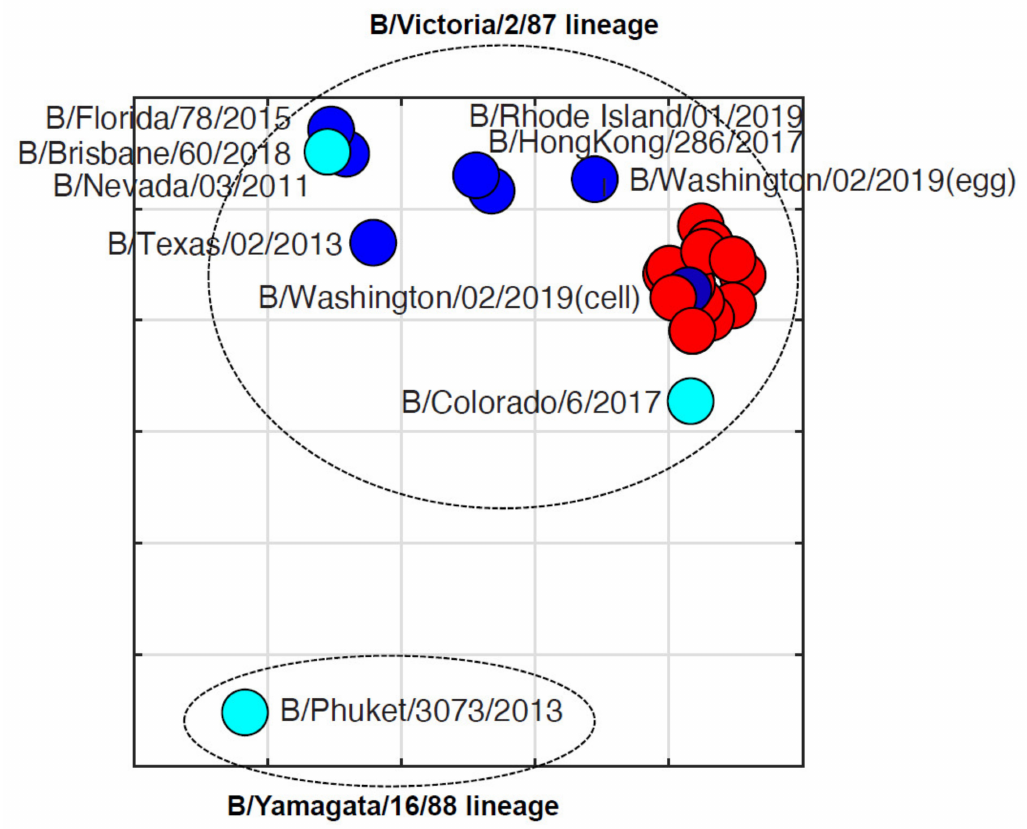
Figure 4. Antigenic cartography of hemagglutination inhibition results of influenza B virus isolates (2019–2020). Each grid represents one unit, a 2-fold change in hemagglutination inhibition titers. The vaccine component strains are labeled in cyan. Strains from the 2019–2020 season in Missouri are shown in red. Additional reference strains are blue. Antigenic cartography was constructed using AntigenMap (https://sysbio.missouri.edu/software/AntigenMap/, accessed on 19 July 2021)